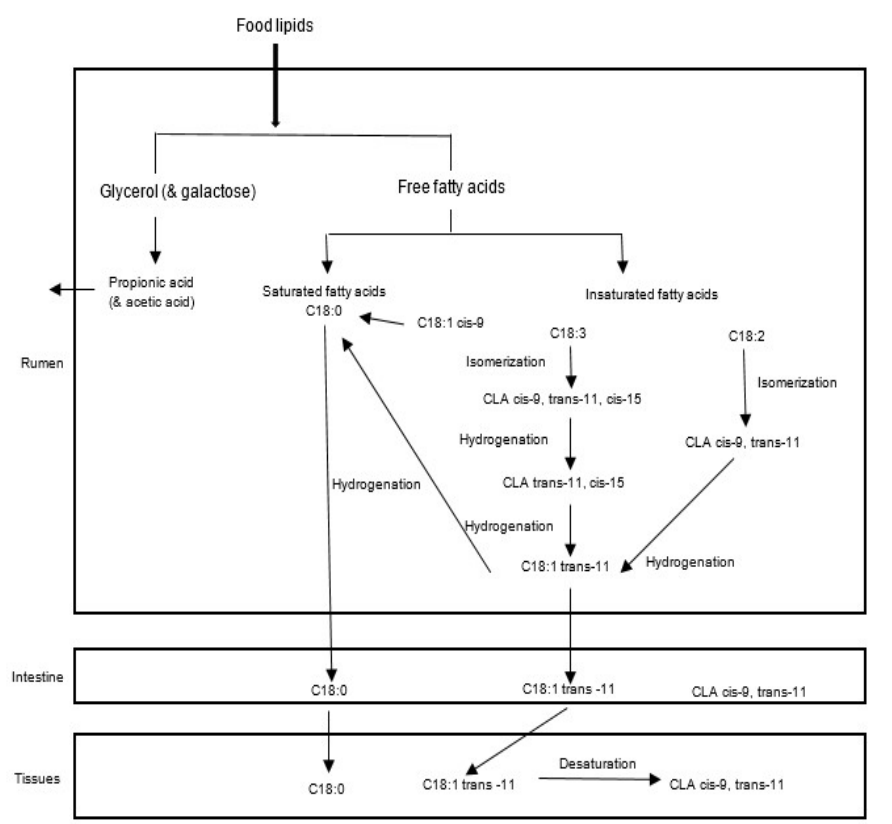
Figure 1. Scheme of ruminal digestion of lipids [22].